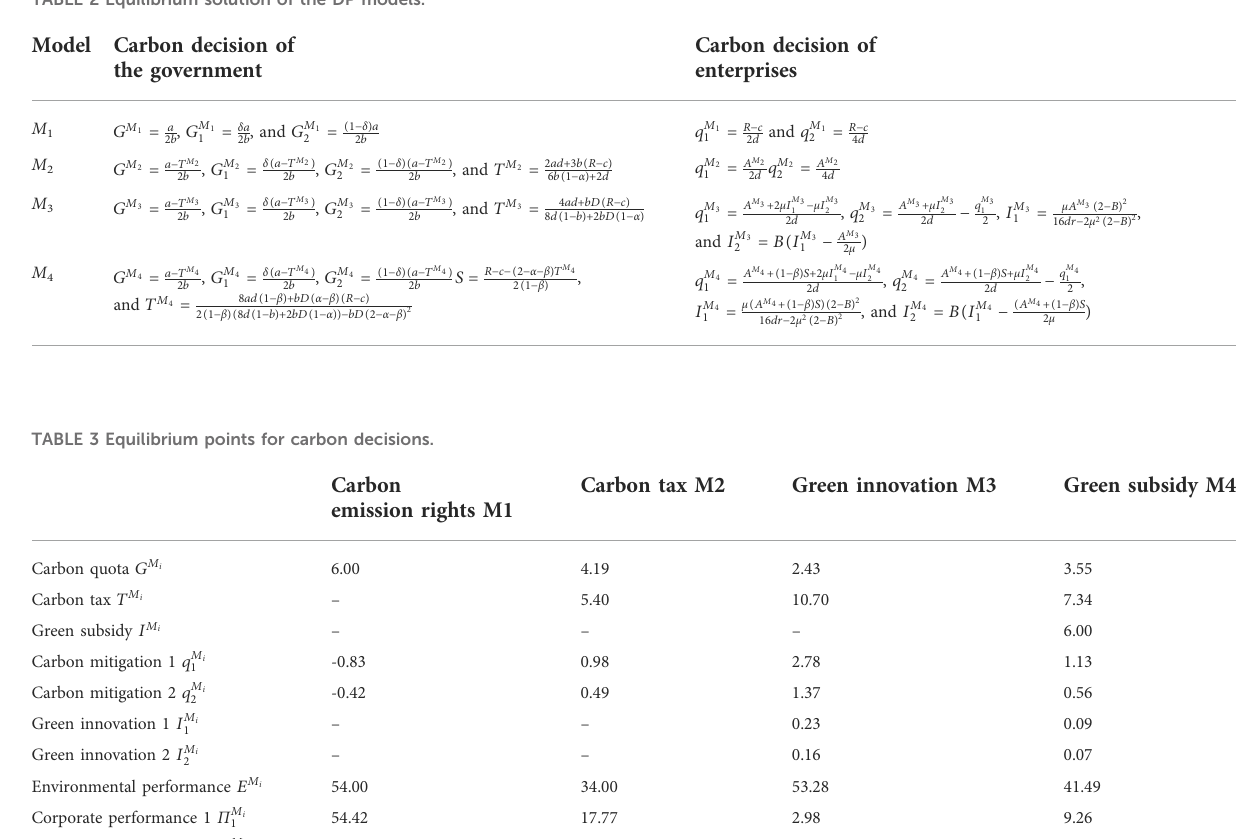
TABLE 2 Equilibrium solution of the DP models.